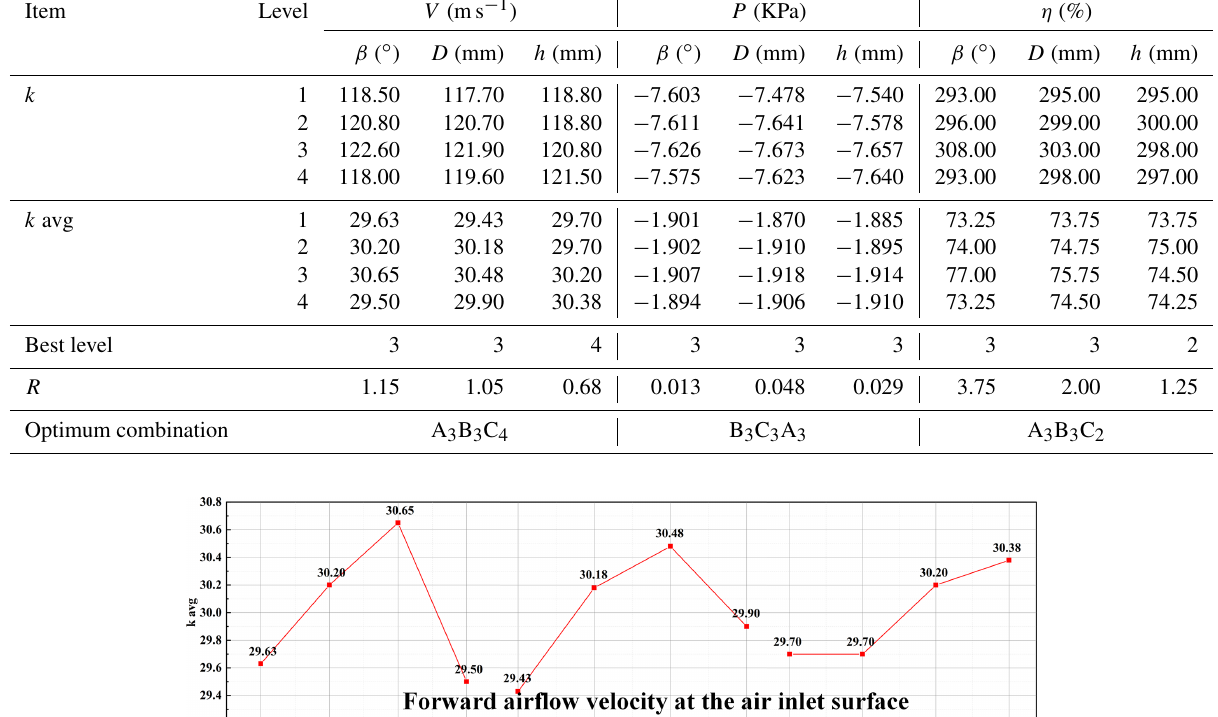
let diameter, i.e. 165 mm; and factor C is optimal at the third